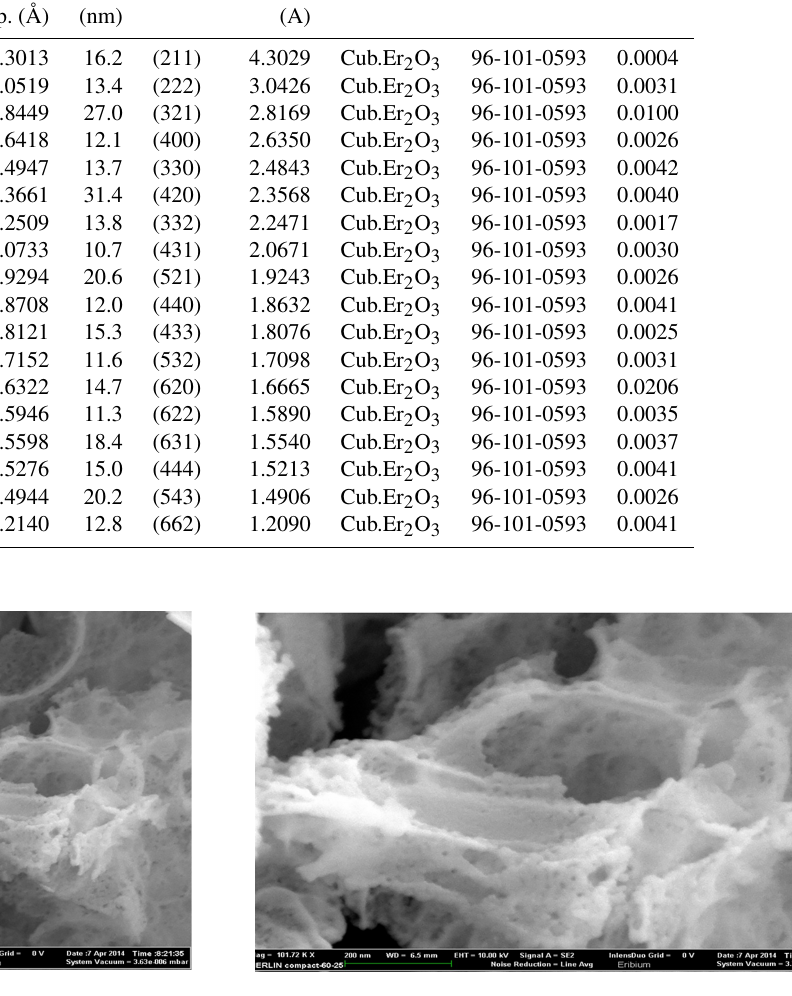
Figure 9. SEM image of nano-sized Er 2 O 3 at 50000 times magni- fication.